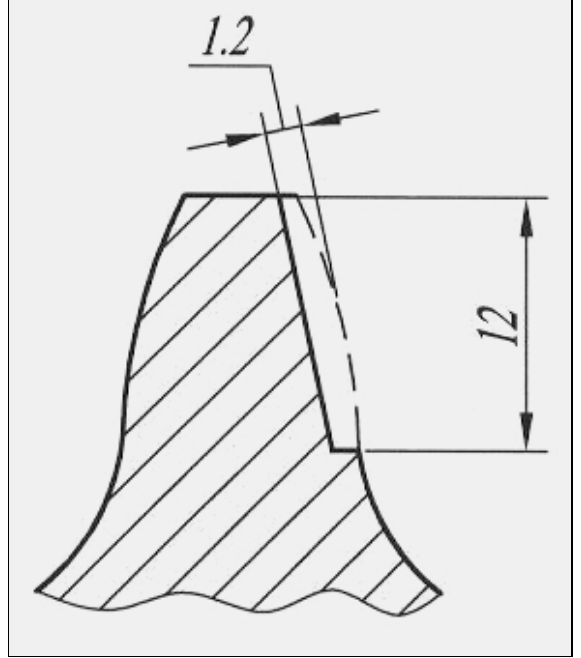
Figure 2. Schematic presentation of the tooth prepared for hard-facing.